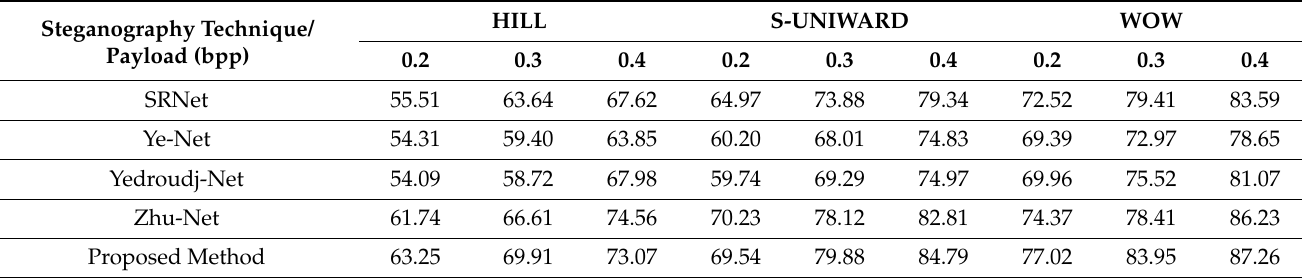
Table 4. The performance assessment while considering Case I.